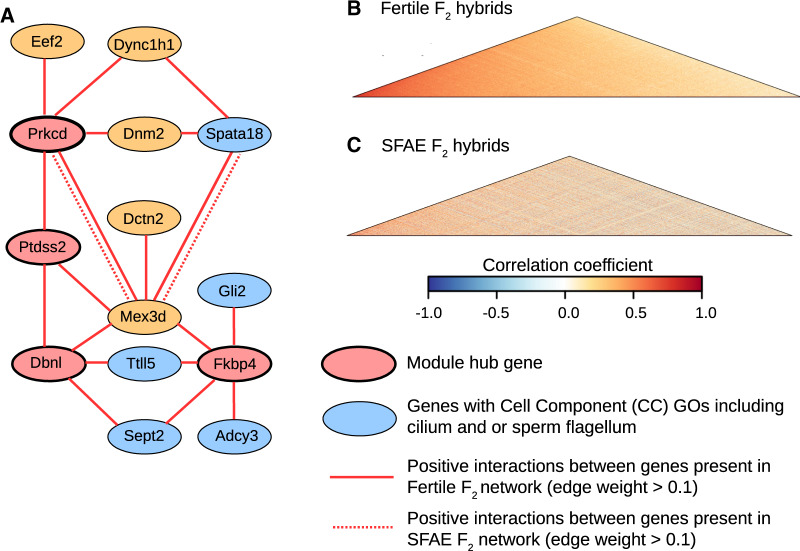
Disrupted interactions of Brown module genes in subfertile F2 hybrids. (A) Interactions between Brown module hub genes (red nodes) and genes with GOs including cilium/and or sperm flagellum (blue nodes) in fertile and SFAE F2 hybrids. Orange nodes indicate intermediate genes with functions potentially related to male fertility. Gene interactions with an edge-weight exceeding 0.1, as estimated using topological overlap matrices, are indicated using continuous and dashed lines for the fertile and SFAE hybrids, respectively. (B and C) Coexpression heatmaps showing pairwise correlations between expression values of Brown module genes in fertile and SFAE F2 hybrids, respectively.